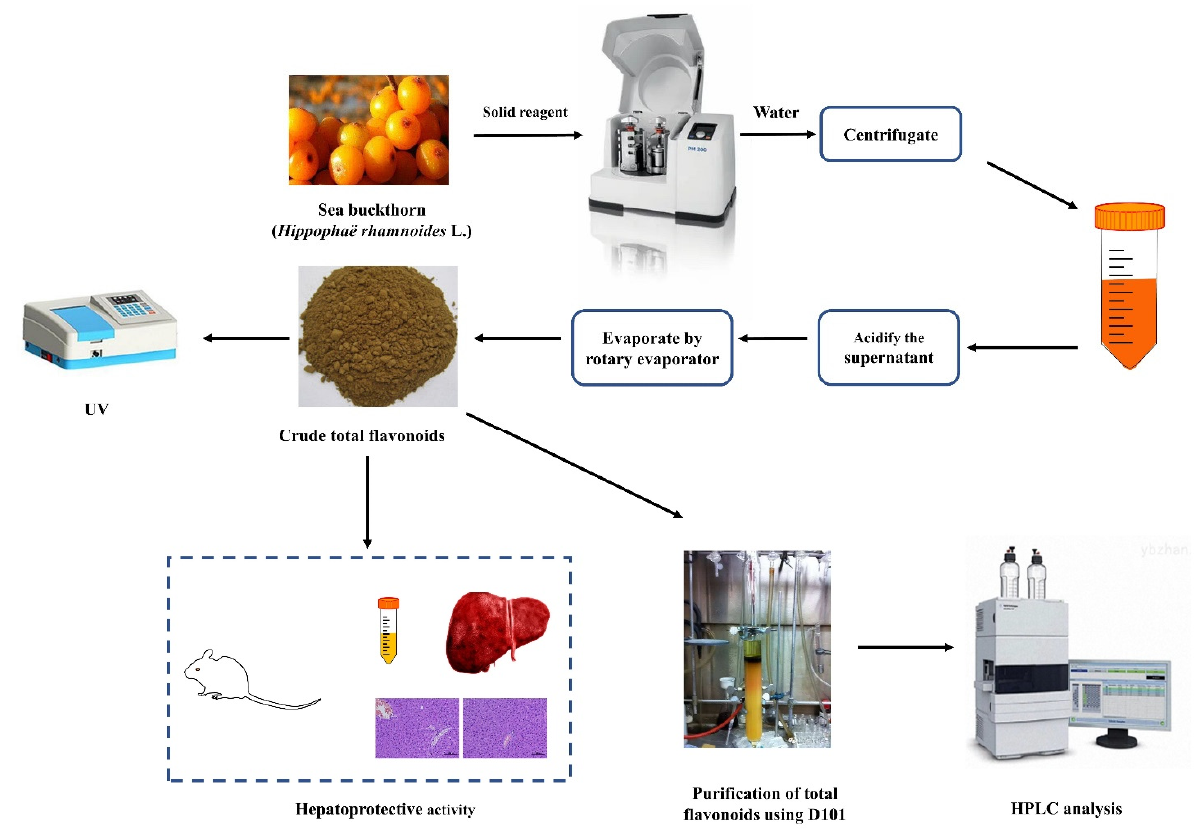
Figure 6. Scheme of MCAE method and further process.